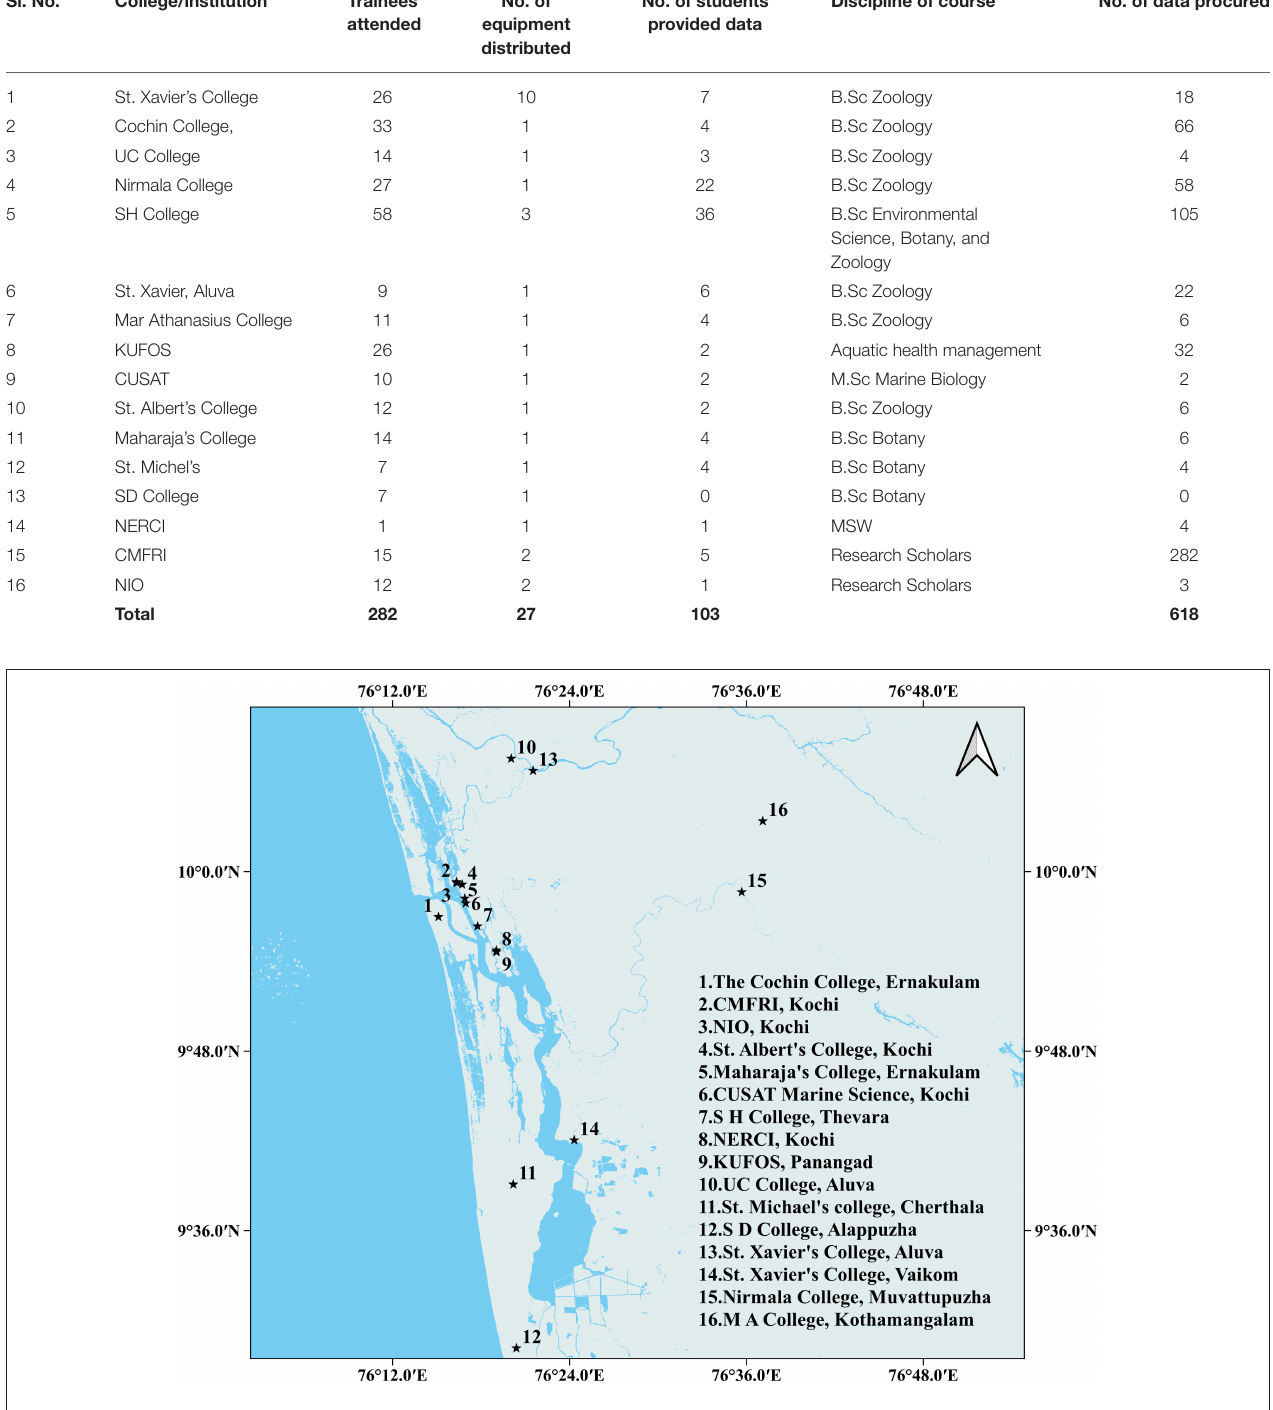
FIGURE 2 | The spatial spread of 16 academic institutions which were part of the citizen science network.